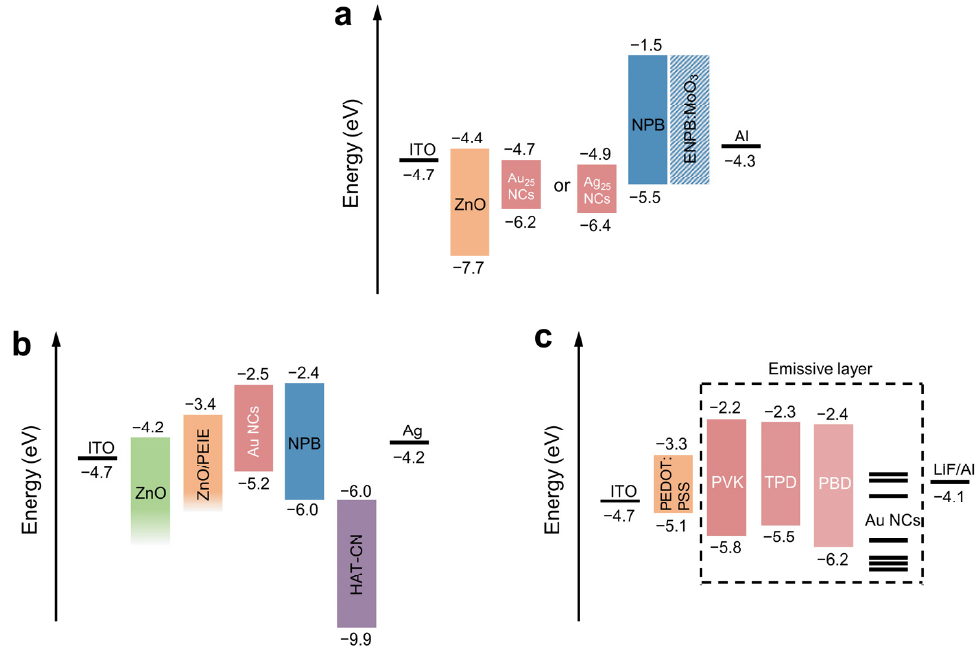
Figure 7. The energy level diagrams of monometallic NCs. ( a ) The energy level diagram of Au or Ag NCs-LEDs. Copyright (2014) Wiley-VCH. ( b ) The energy level diagram of Au NCs-LEDs while the Au NCs with higher PLQY. Copyright (2015) Royal Society of Chemistry. ( c ) The energy level diagram of LEDs with yellow Au NCs and a blue-emitting organic host material mixed as the light-emitting layer. Copyright (2018) Springer Nature.